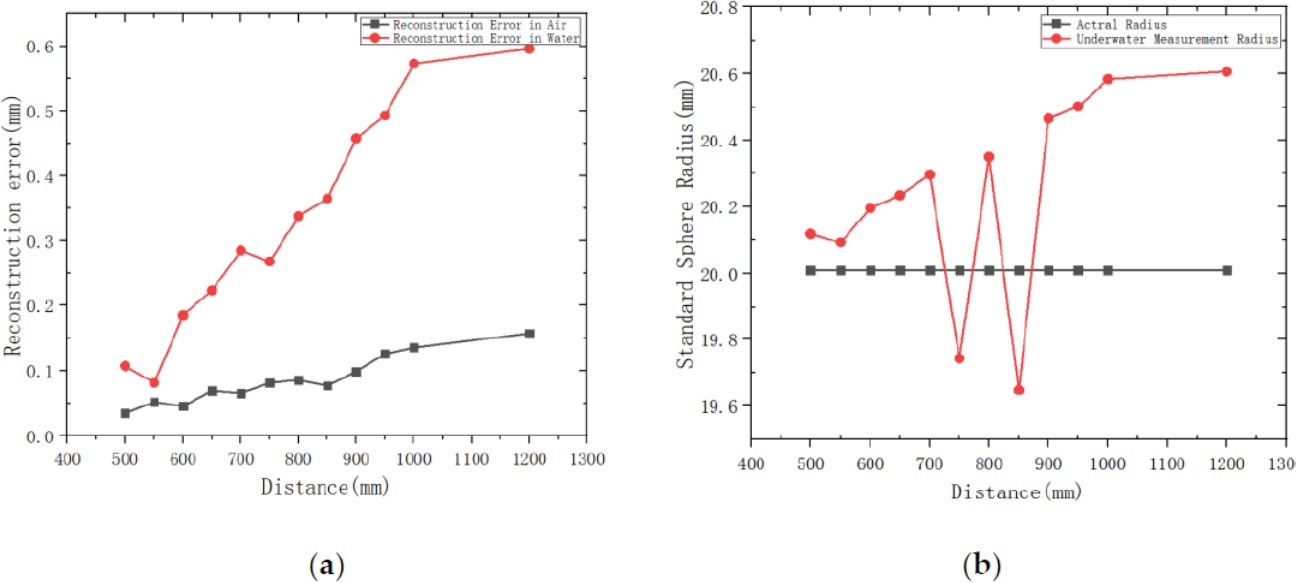
Figure 11. Relationship between the measured value of standard error sphere radius and the measured distance. ( a ) Reconstruction error results in water and air; ( b ) Reconstruction of standard ball diameter at different